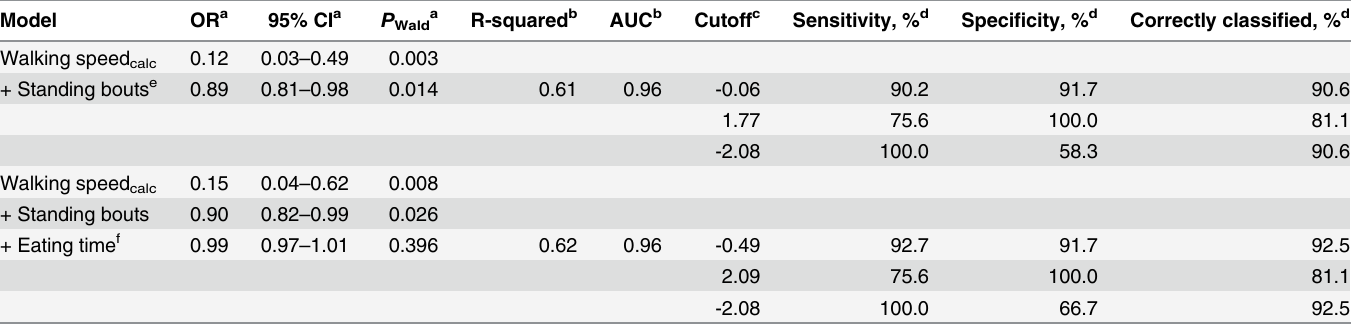
a Odds ratio, 95% con fi dence interval and P b R-squared and area under the receiver operating characteristics curve of the model. c Cutoff-value after application of model equation d Sensitivity, Speci fi city and correctly classi fi ed study animals of the model on corresponding cutoff-value.